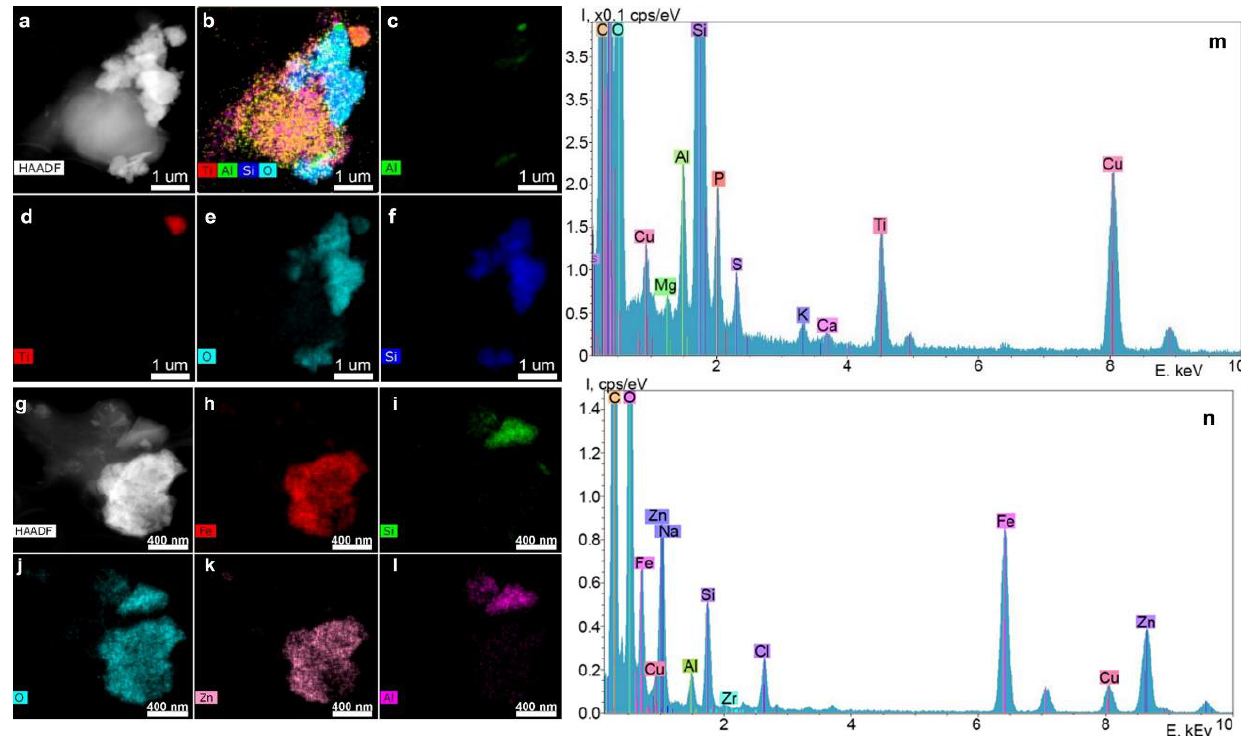
Figure 4. STEM image of particles with z-contrast ( a,g ), chemical element distribution maps ( b – f , h – l ) and the corresponding energy-dispersive spectrum ( m,n ).